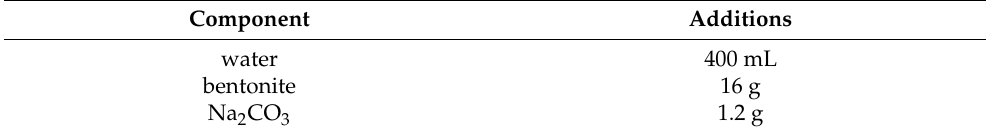
Table 5. Composition of one